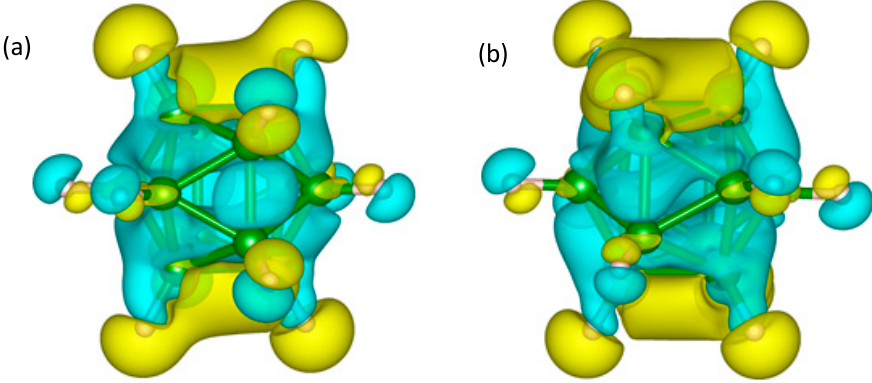
Figure 1. The charge density difference of B 12 H 12 closo anion deformed along C 3 symmetry axis ( a ) and C 2 axis ( b ). Yellow colour is for charge accumulations, cyan–charge depletion. Yellow balls are for colour,